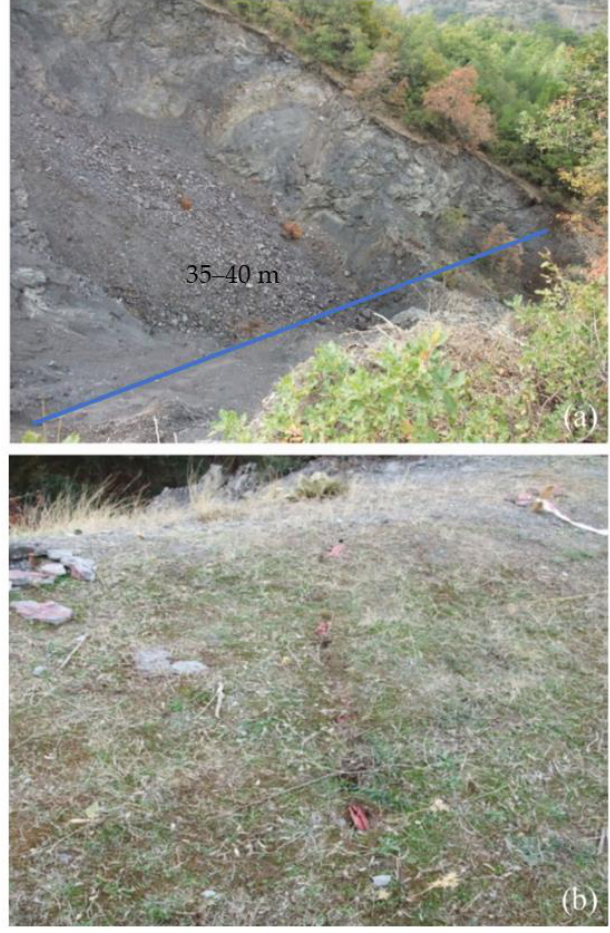
Figure 6. View of subsidence developed throughout the TBM excavations ( a ); tunneling induced surface cracks adjacent to the tunnel alignment ( b